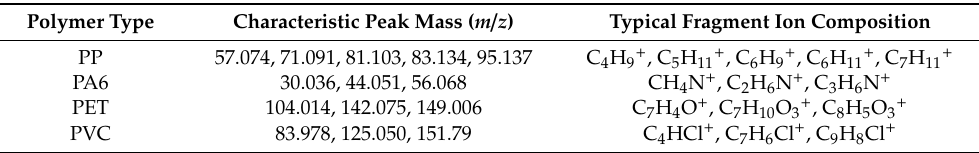
Table 2. Typical fragment ions of four microplastic MP standard samples.